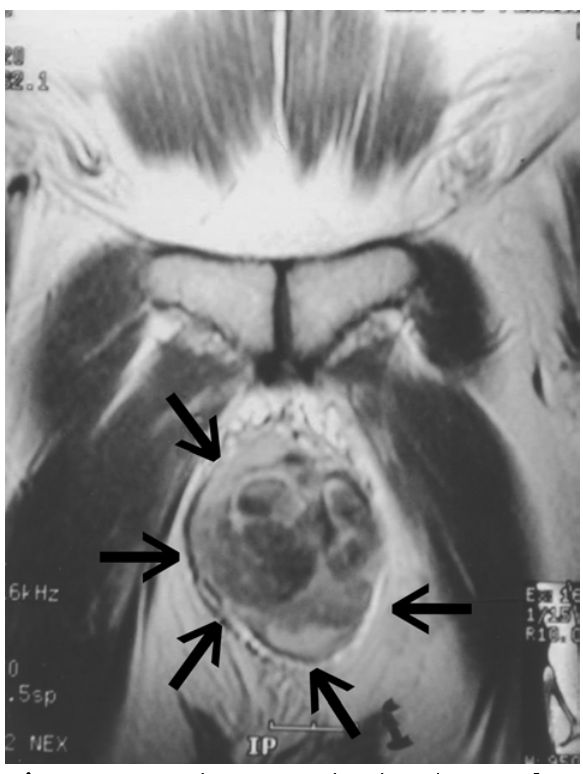
Figure 1 – Magnetic resonance imaging. The coronal T1- weighted image of the base of the penis shows an infiltrative tumor leading to destruction of cavernous bodies (arrows).